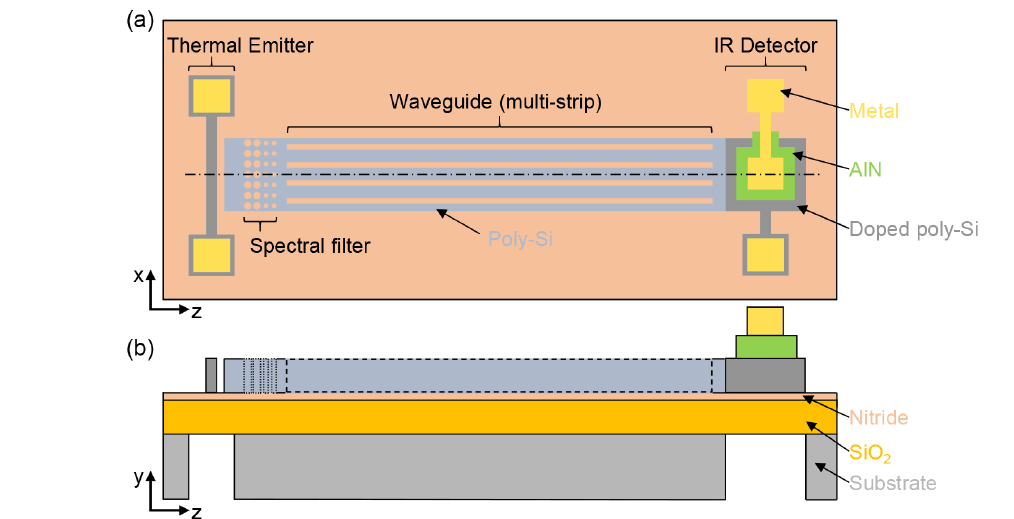
Figure 1. Schematic of an integrated, non-dispersive mid-infrared (NDIR) sensor system. (a) Top view of the system, depicting a thermal emitter, a spectral filter, a multi-strip waveguide, and an infrared (IR) detector. (b) Cross section through the dash-dotted line shown in panel (a)